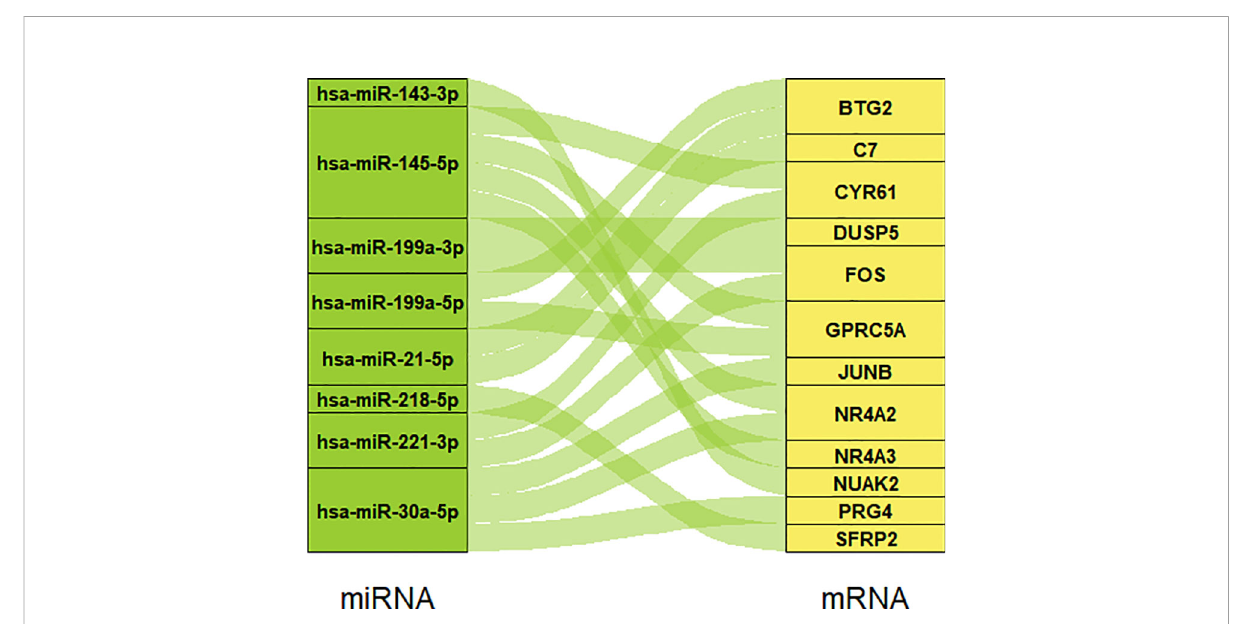
FIGURE 3 The miRNA-mRNA regulatory network. Eight miRNAs and 12 mRNAs construct 17 regulatory